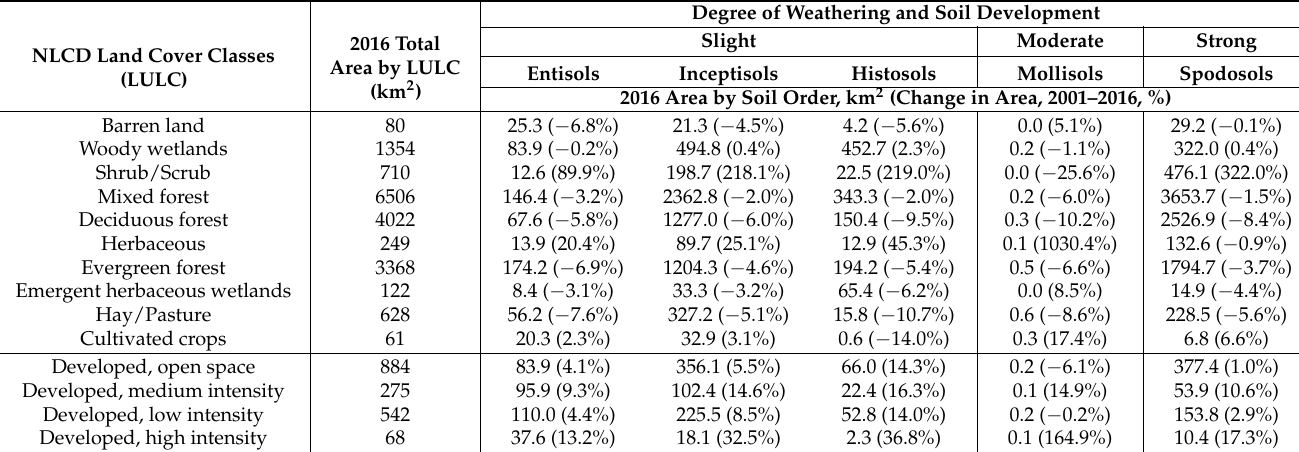
Table 11. Land use/land cover (LULC) change by soil order in New Hampshire (USA) from 2001 to 2016. NLCD Land Cover Classes